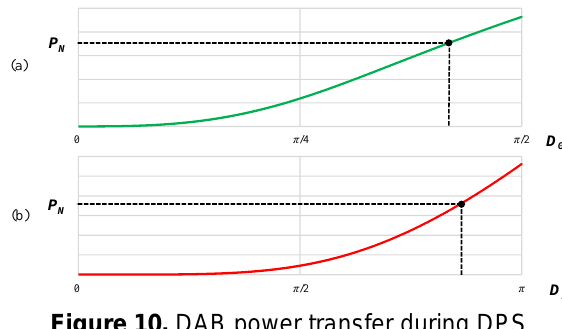
Figure 10. DAB power transfer during DPS